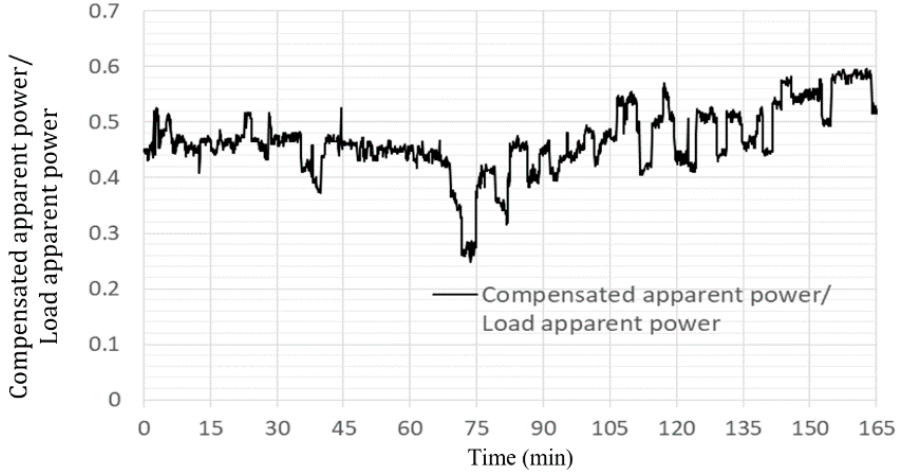
Figure 25. Evolution of the compensated apparent power during the recordings (p.u.).